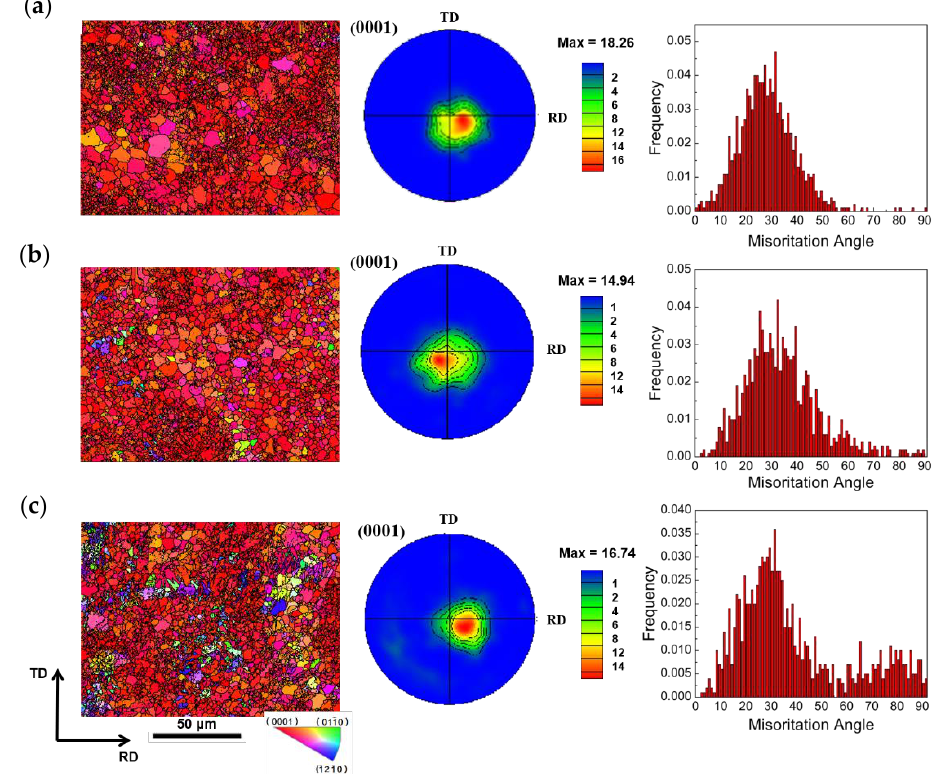
Figure 8. EBSD-measured IPF maps, (0001) PFs, and misorientation-angle distribution of ASR: ( a ) ASR-1.5 mm, ( b ) ASR-0.75 mm, ( c ) ASR-0.5